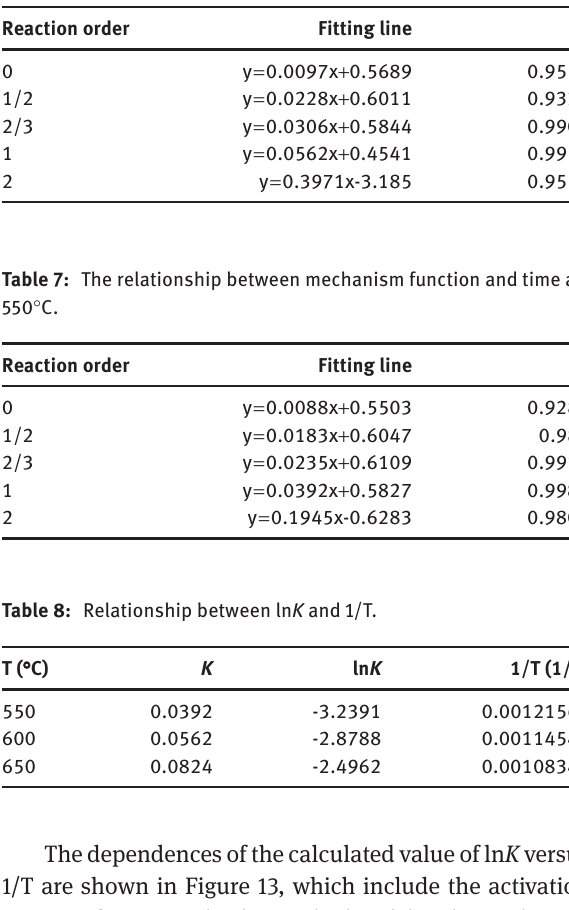
Figure 12: The relationship between G ( α ) and time at 550 ° C on n = 0, 1/2, 2/3, 1, 2, respectively. Table 6: The relationship between mechanism function and time at 600 ° C.